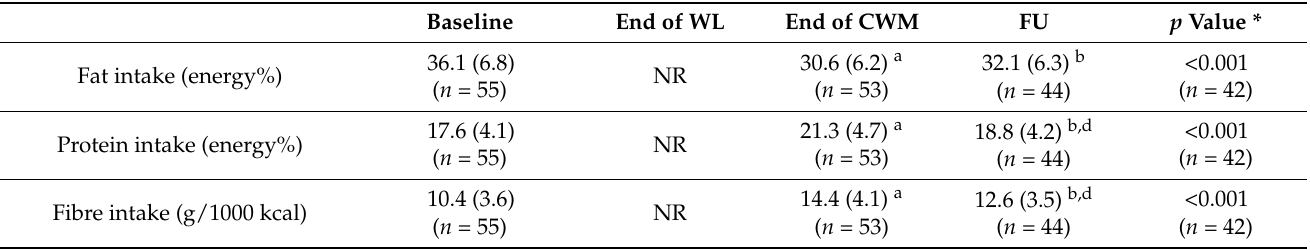
Figure 2. Association between dietary carbohydrate (CHO) intake during follow-up (FU) and weight regain ( n = 52).